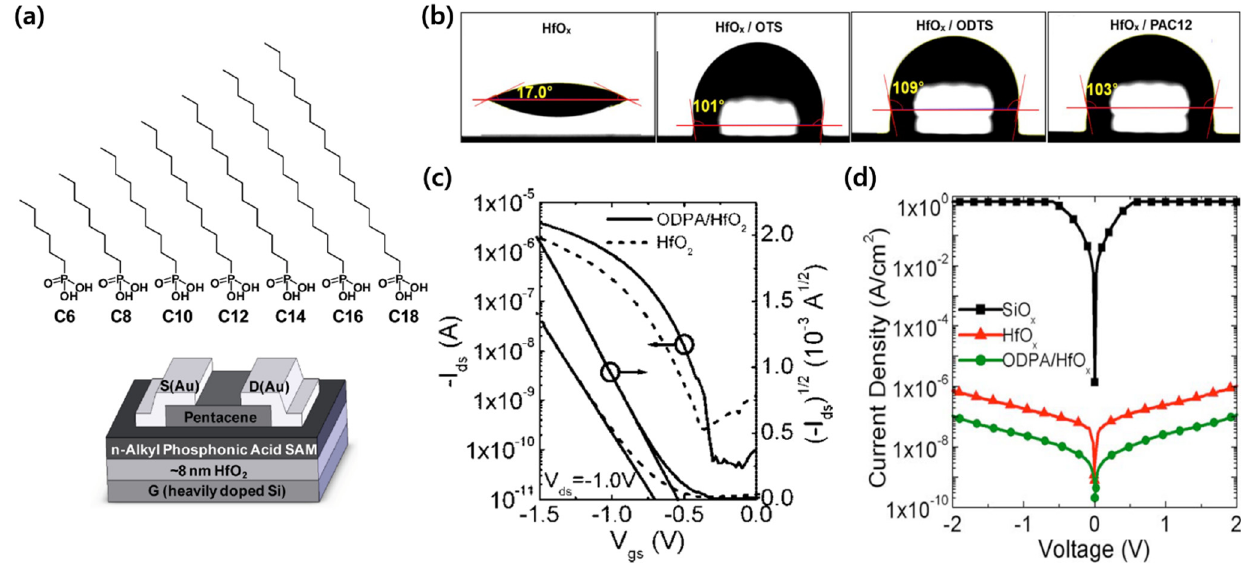
Figure 3. SAM treatment on HfO 2 gate dielectrics. ( a ) Chemical structure of phosphonic acid SAMs with various carbon chain lengths; n-hexylphosphonic acid (HPA), n-octylphosphonic acid (OPA), n-decylphosphonic acid (DPA), n-dodecylphosphonic acid (DDPA), n-tetradecylphosphonic acid (TDPA), n-hexadecylphosphonic acid (HDPA), and n-octadecylphosphonic acid (ODPA) (adapted from [45] with permission from the American Chemical Society). ( b ) Water contact angle of pristine HfO x and HfO x treated with OTS, ODTS, and DDPA, respectively (adapted from [46] with permission from Elsevier). ( c ) Comparison of transfer characteristics with or without the ODPA treatment of HfO 2 (adapted from [47] with permission from the American Chemical Society). ( d ) Comparison of the leakage current for SiO x , bare HfO x , and ODPA-treated HfO x (adapted from [48] with permission from AIP Publishing).